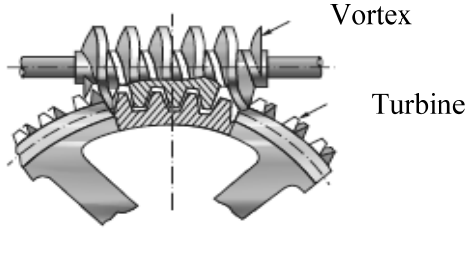
Figure 2. Vortex and turbine.